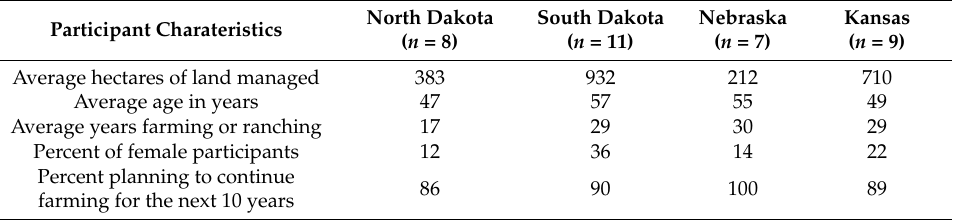
Table 1. Summary of participant and farm system characteristics from a farmer and rancher focus group series from the Northern Great Plains exploring woody biomass potential,